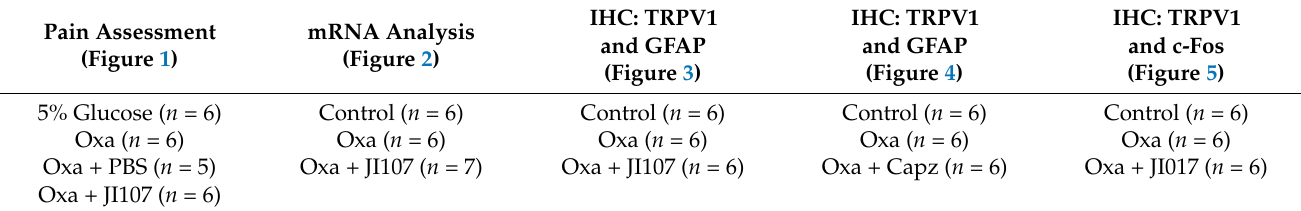
Table 1. Experimental groups.